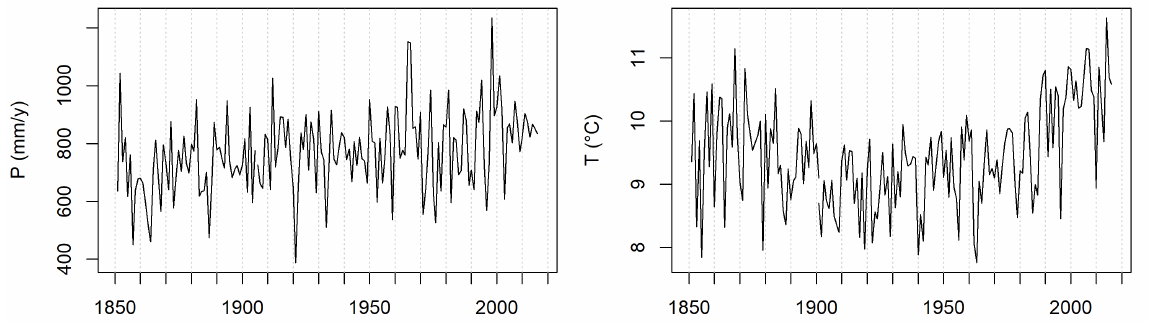
Figure 5. Yearly precipitation (P) and mean yearly temperature (T) for 1851–2016 based on observations.